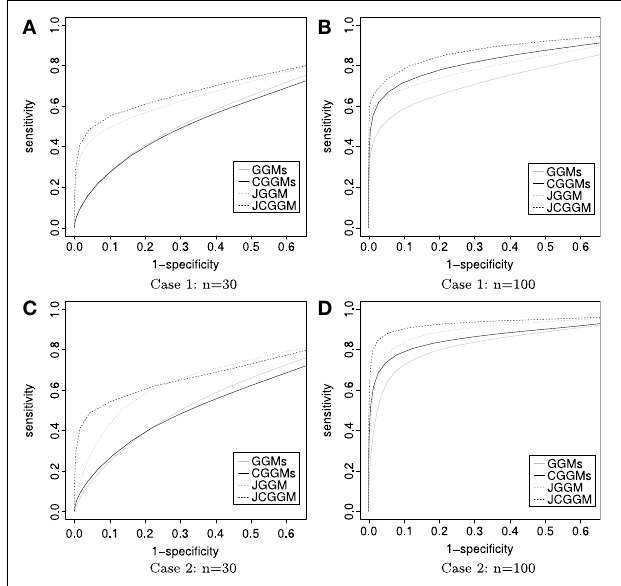
FIGURE 2 | ROC curves: the average ROC curves are presented. Throughout all scenarios, the JCGGM performs the best. (A) With no external variable and a small sample size, JGGM, and JCGGM perform well. (B) With no external variable and a large sample size, JCGGM performs the best, followed by CGGM and JGGM. These two performs similarly. (C) With external variables and a small sample size, only JCGGM performs well. (D) With external variables and a large sample size, JCGGM performs the best, followed by JGGM and CGGM.